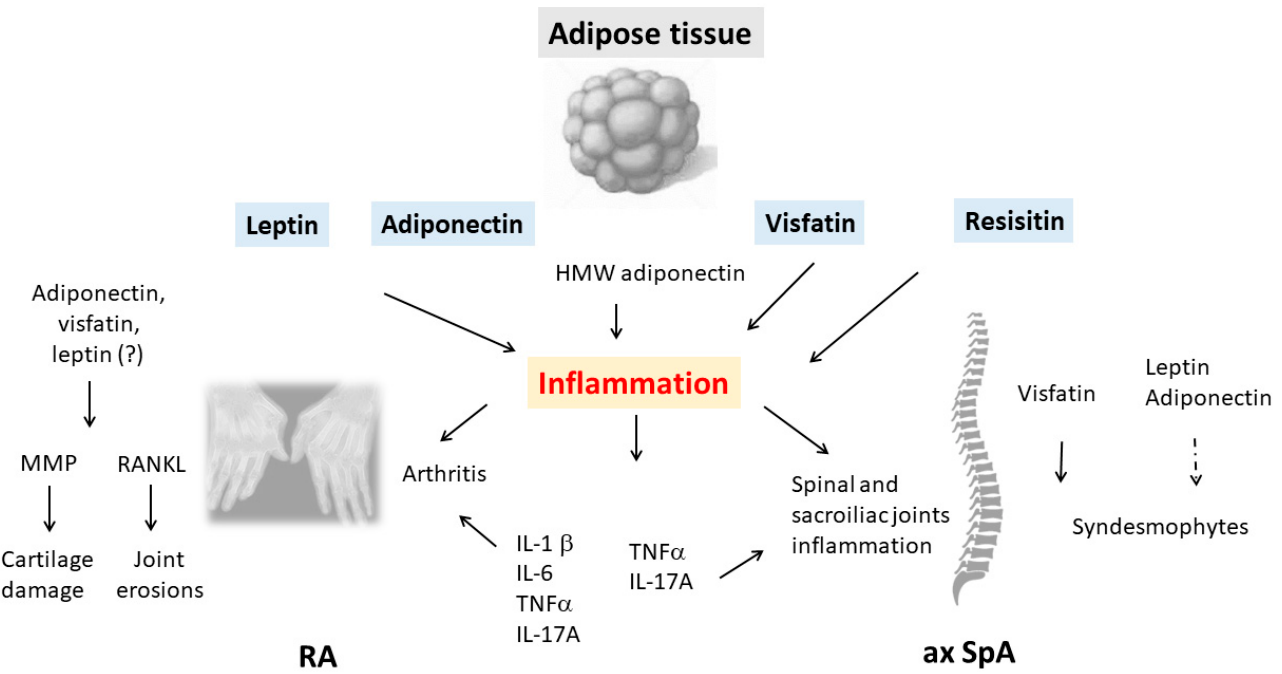
Figure 1. The contribution of adipokines to joint modification in inflammatory rheumatic diseases (IRDs). Several factors are produced by the adipose tissue, collectively called adipokines. Leptin, adiponectin, visfatin and resistin are all involved in inflammation of the joints/axial skeleton in rheumatoid arthritis and axial spondyloarthritis. By stimulating pro-inflammatory cytokine release from innate and adaptive immune cells, adipokines induce an inflammatory milieu. In turn, pro- inflammatory cytokines may promote the release of adipokines. Leptin, visfatin and resistin all have pro-inflammatory effects on the joints and/or axial skeleton, while the effects of adiponectin on the inflammatory process are variable and depend on its isoform, with the high-molecular-weight isoform driving a pro-inflammatory reaction. Due to the interplay that adipokines have with specific factors involved in cartilage and bone metabolism, they may contribute to cartilage degradation and bone erosions in RA or spinal ligamentous ossifications in ax SpA (RA: rheumatoid arthritis; ax SpA: axial spondyloarthritis; HMW: high molecular weight; MMP: metalloproteinases; RANKL: receptor activator of nuclear factor κ B ligand; dashed arrow: inhibitory effect; lined arrow: stimulating effect). A number of studies have reported that adiponectin levels are increased in the serum and in the synovial fluid of patients with RA compared to healthy controls or patients with OA [31,45–52]. Adiponectin levels were found to correlate with the disease activity of RA in certain studies. The synovial tissues of patients with RA, especially fibroblast-like synoviocytes, expressed adiponectin and its receptors, AdipoR1 and AdipoR2 [53]. In addition, in an experimental model, adiponectin alone or in combination with IL-1 beta may induce the release of IL-6, IL-8 and PGE2 by fibroblast synoviocytes [54]. The